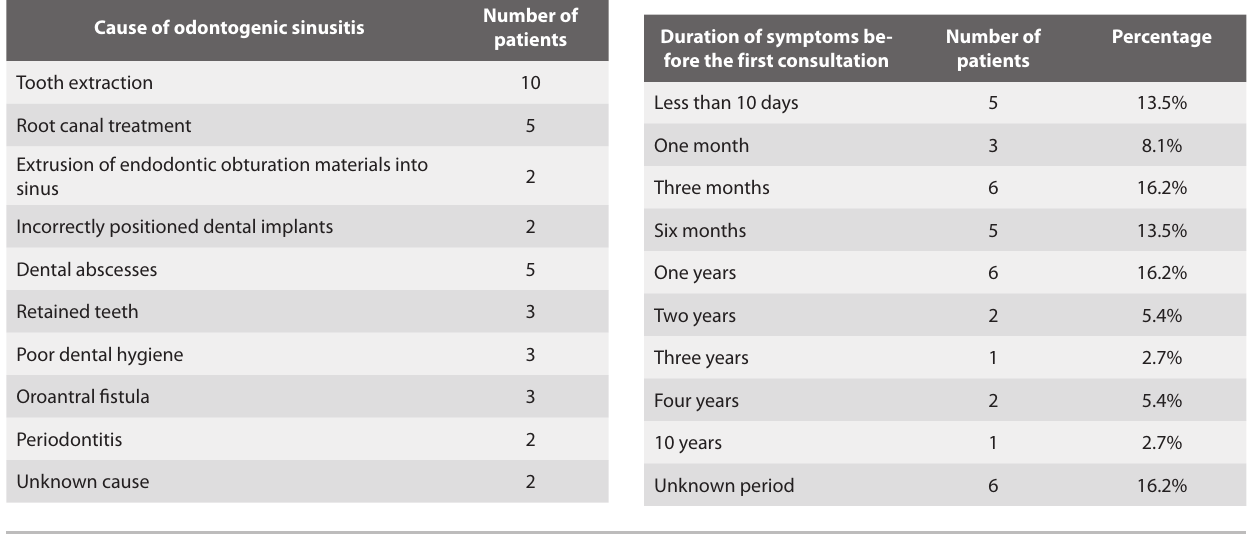
Table 1. Dental origin of sinusitis in 37 patients. Table 2. Duration of symptoms before the first consultation at Odense University